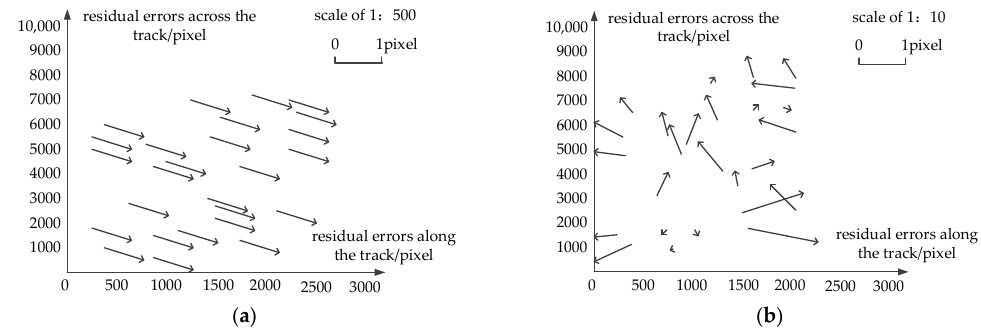
Figure 6. Residual distribution of the check points: ( a ) Residual distribution of direct positioning; ( b ) Residual distribution after external calibration. ( b ) Residual distribution after external calibration.